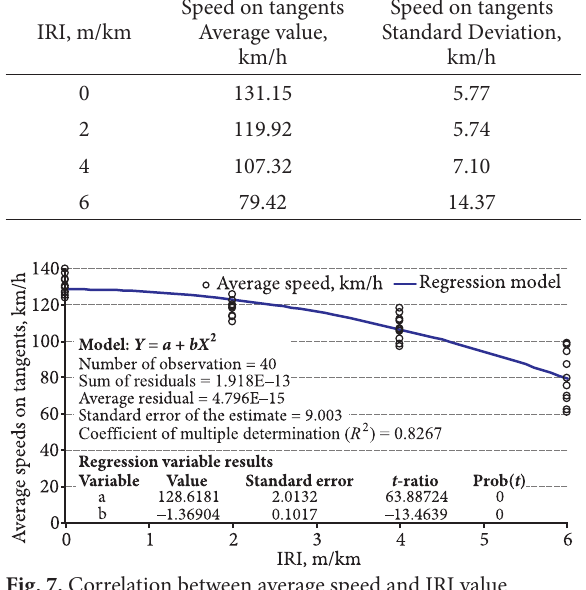
Fig. 7. Correlation between average speed and IRI value